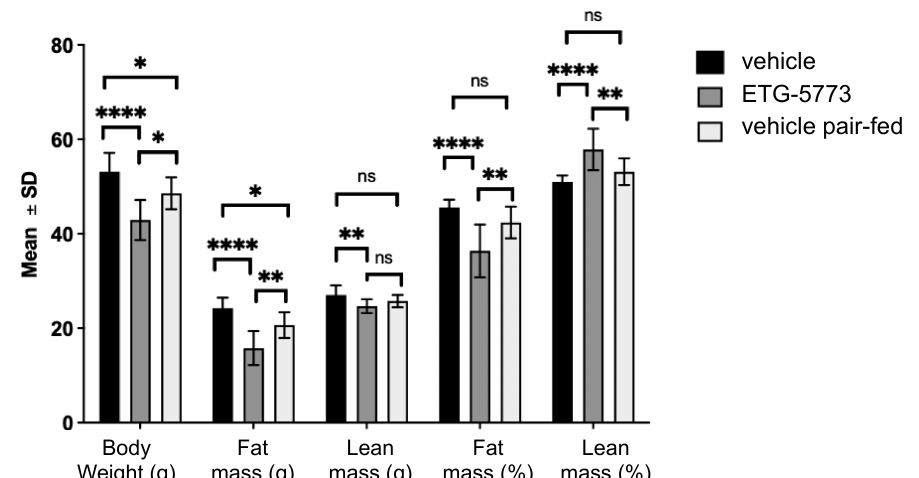
Figure 4. Body composition analysis in DIO mice treated with ETG-5773. The graph shows changes in absolute body weight, fat mass, and lean mass of mice after 22 days of treatment as well as relative amounts of fat and lean mass. Animals were treated orally twice a day with 15 mg/kg ETG-5773 or with the corresponding vehicle for vehicle or pair-fed groups. * p < 0.05, ** p < 0.01, **** p < 0.0001, ns: non-significant. ANOVA mean SD, n = 12 vehicle and ETG-5773, n = 8